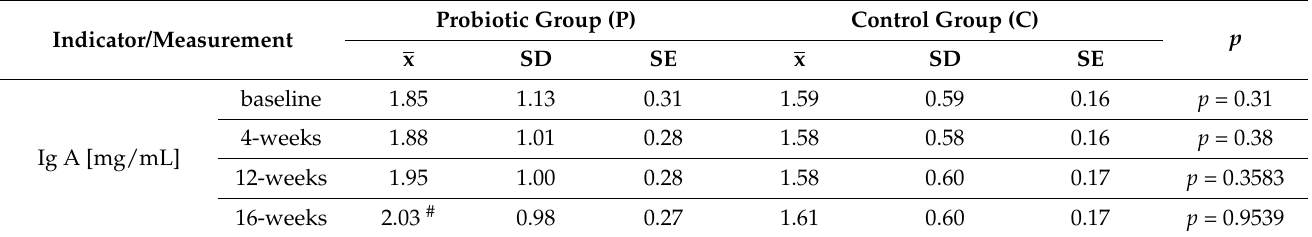
Table 7. Immunoglobulin A (IgA) concentration in blood serum at follow-up measurements during supplementation intervention.